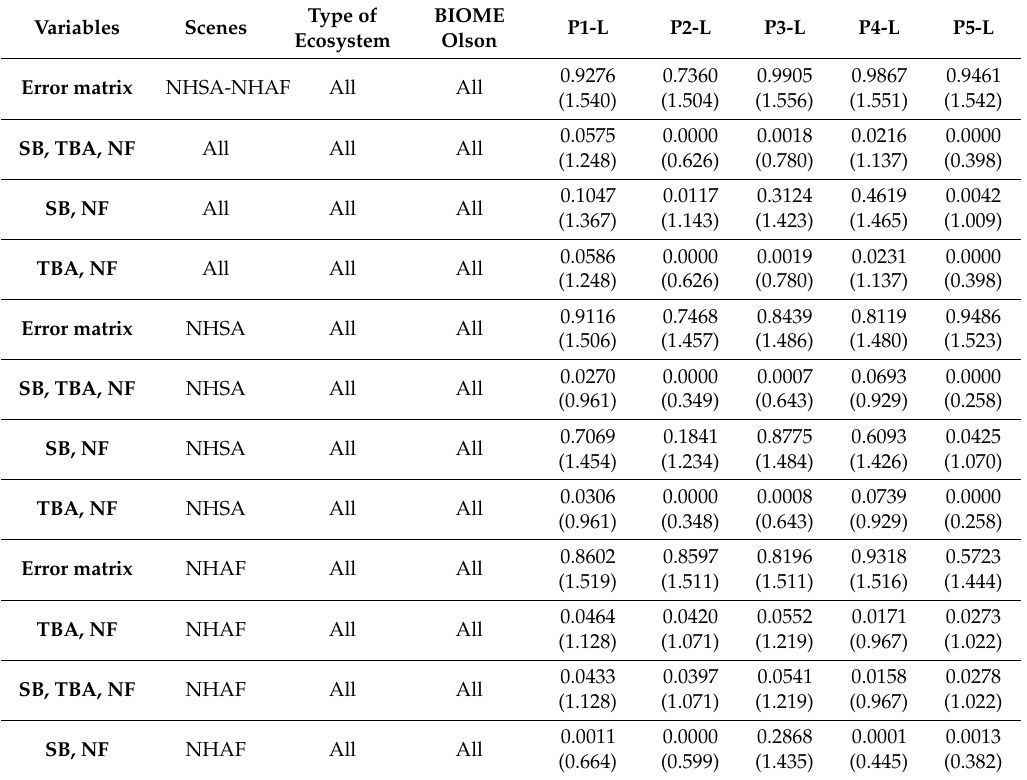
Table 3. p -values of permutation test for validation under di ff erent scenarios and variables. The statistic of the test is the true Riemannian distance (in parenthesis) between the product and reference matrices. Note that the true Riemannian distances near to zero are associated with p-values close to zero. Rejecting the permutation test with such small p-value means that a random generator cannot obtain the same observed values for the product. The opposite conclusion can be addressed when true Riemannian distance is very far from zero, then the permutation test, with a p value near to 1, cannot be rejected. It means that the data measured by the product can be easily obtained by a random generator, without any technological expertise. P-values of the table also serves for ordering the product respect the performance under the variables of interest. The tests also allow ordering among statistical significant groups of